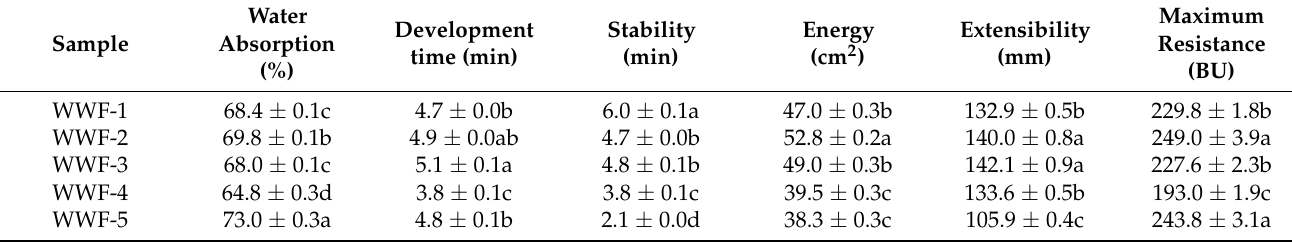
Table 3. Dough rheological properties of WWF obtained by different milling methods.